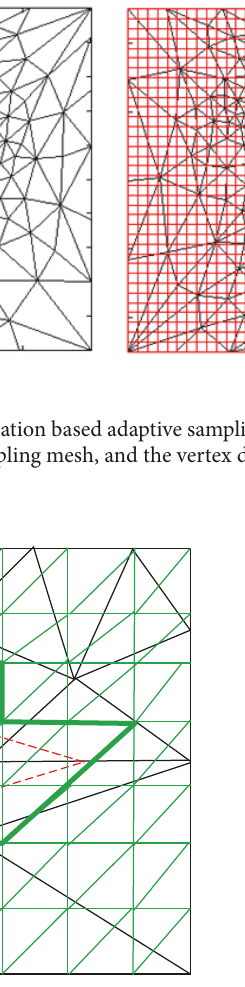
Figure 3: Selection of the associated faces with respect to the target face. Black triangles denote the parametrization mesh, green triangles denote the sampling mesh, and red solid triangle denotes a target face S . The red dash triangles denote the enlarged face, and the green bold lines denote the collection S 󸀠 of the selected faces of the sampling mesh.